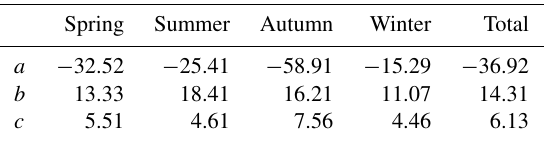
Table 5. Coefficients of the model equations to calculate latent heat flux (LE). The equations have the general form: LE = a + b · v a + c · (cid:49)e . Coefficients are shown for the meteorological seasons 2014– 2015 and the entire data